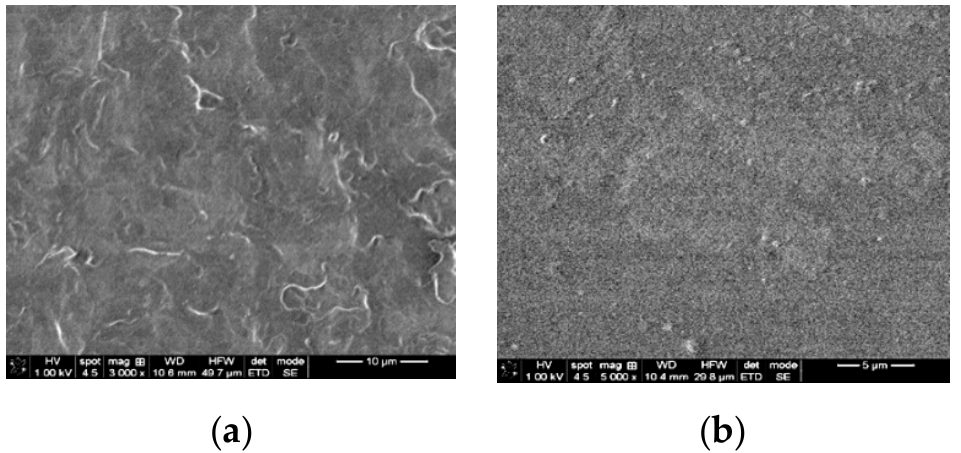
Figure 1. SEM images of ( a ) Reference (R); ( b ) F-UBE-HPC; R—bioadhesive oral film without active lichen extract; F-UBE-HPC—bioadhesive oral film loaded with U. barbata dry ethanol extract.